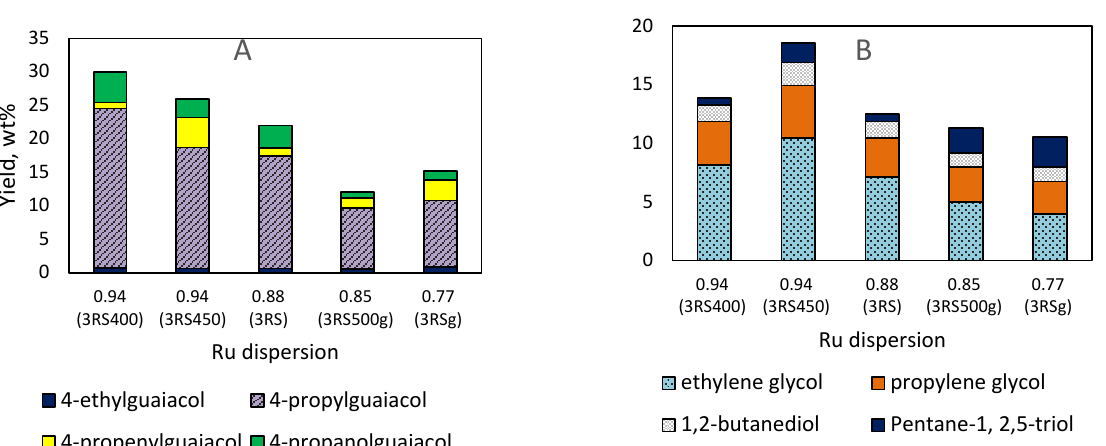
Figure 3. The influence of Ru dispersion in the catalyst on the yields of monomers from lignin and ( A ) polyols from polysaccharides ( B ).